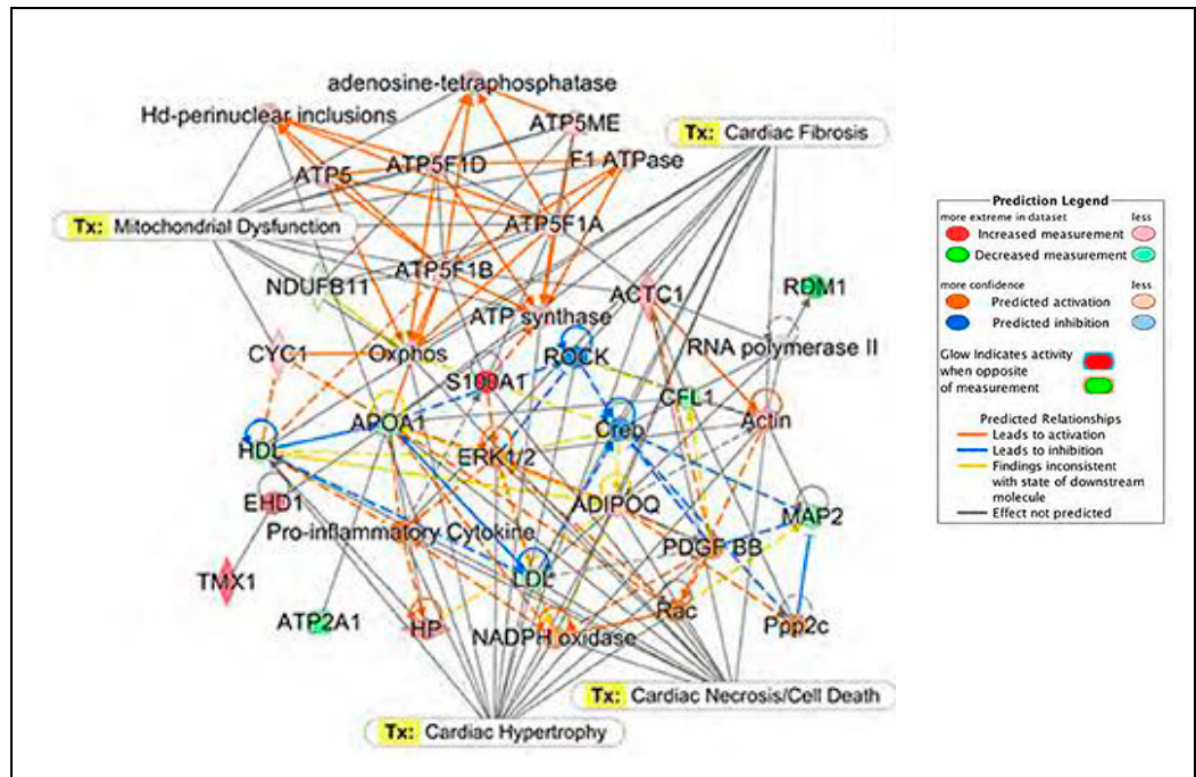
Figure 4. IPA analysis of differentially expressed proteins in diabetic mice with predicted biological processes. Differentially expressed proteins in diabetic mice (compared to WT) were engaged in biological processes such as mitochondrial dysfunction, cardiac fibrosis, cardiac hypertrophy and cardiac necrosis/cell death. The color nodes in the network of graphical relations between proteins imply the names of the proteins that were identified in the experimental proteomic datasets (red—protein upregulation, green—protein downregulation) and the color intensities are related to the magnitude of the expression state. This figure was adapted from ref.